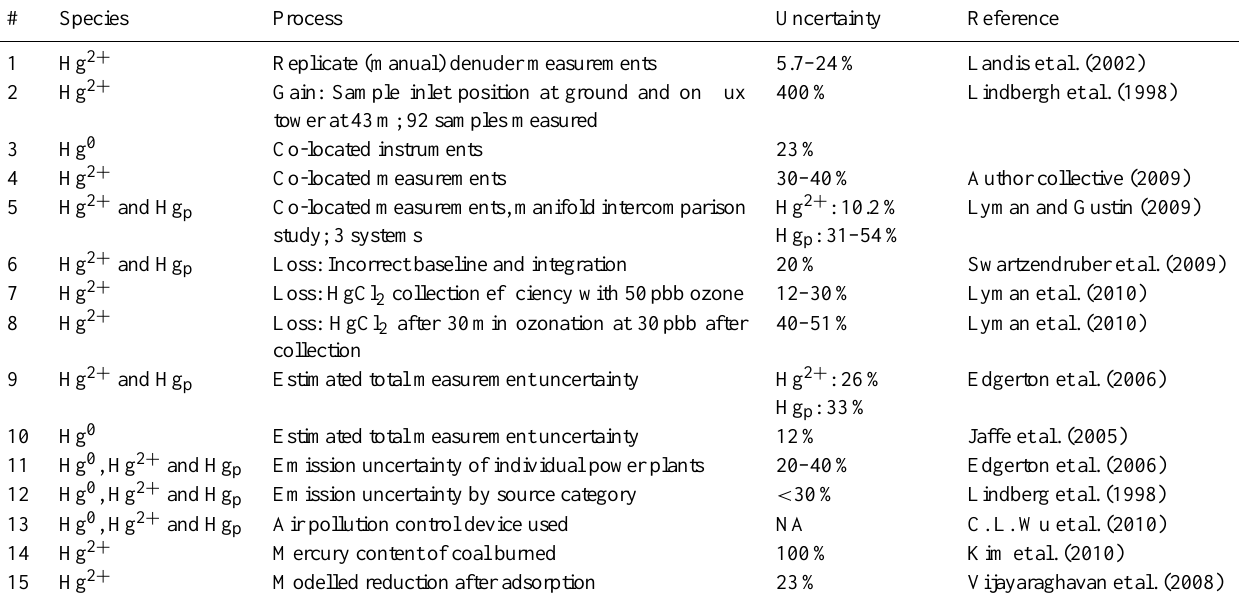
Table 5. Quantitative uncertainty data for sampling, measurement (Tekran 2537A/1130/1135), emission and atmospheric chemistry-related parameters. Data are presented as calculated by the original authors. Summary discussed in Sect.